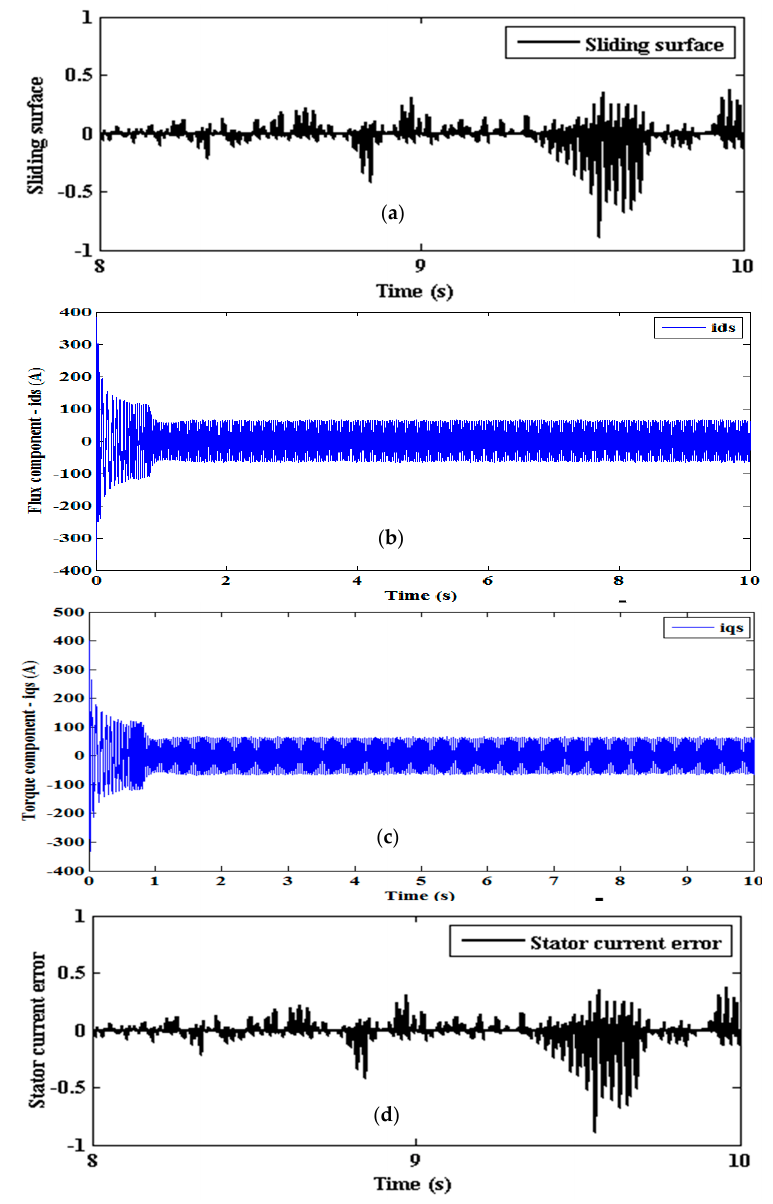
Figure 23. SMLO 1 ( a ) sliding surface; ( b ) flux component of stator current; ( c ) torque component of stator current; and ( d ) stator current error.